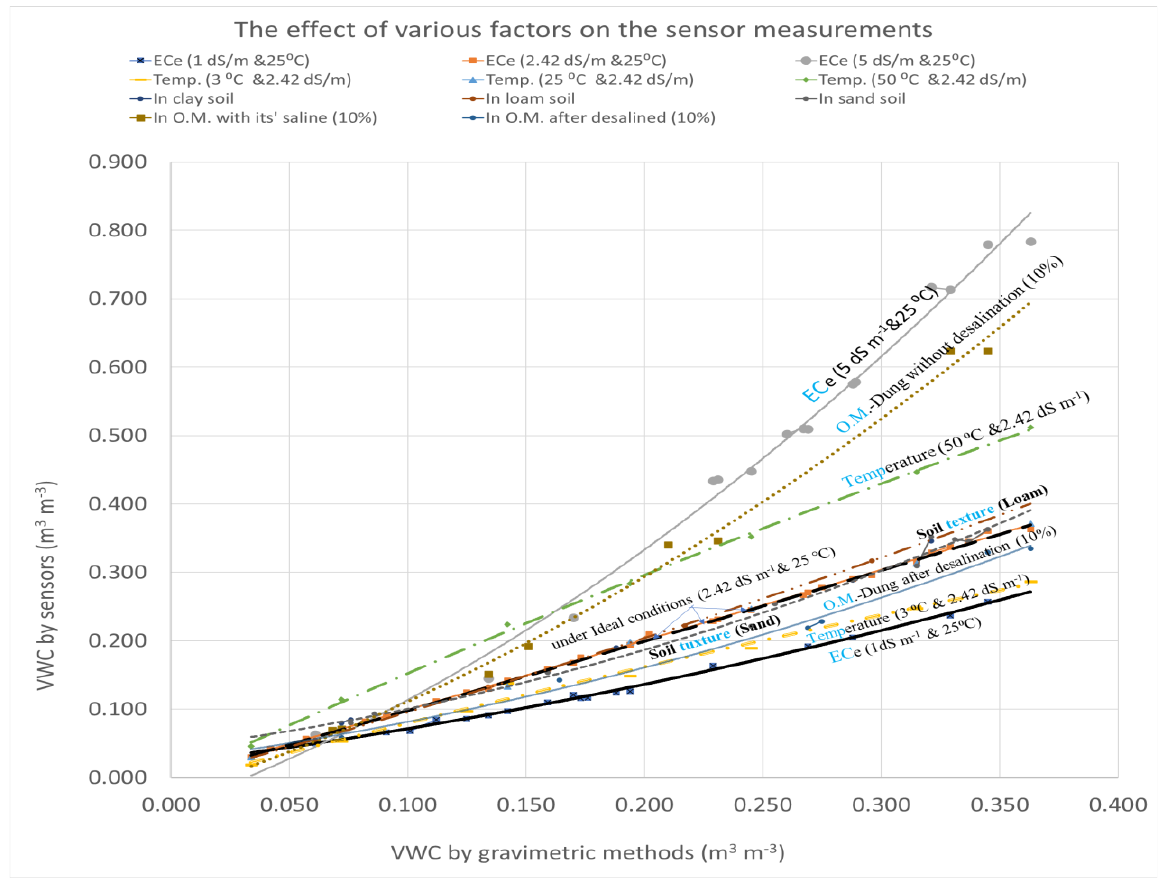
Figure 2. The influence of various factors on sensor measurements.